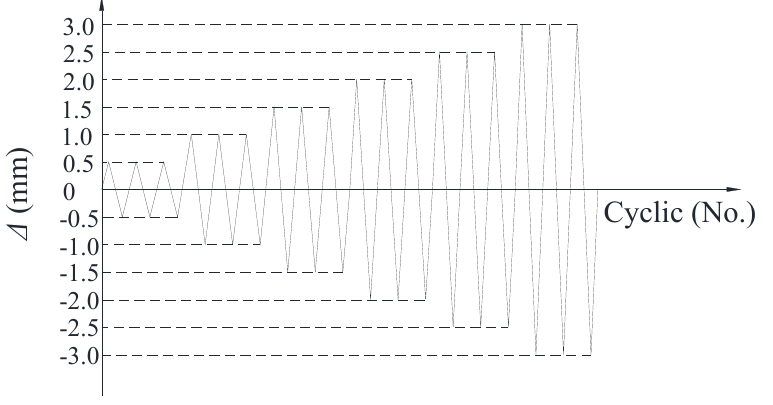
Figure 3. Loading procedure.